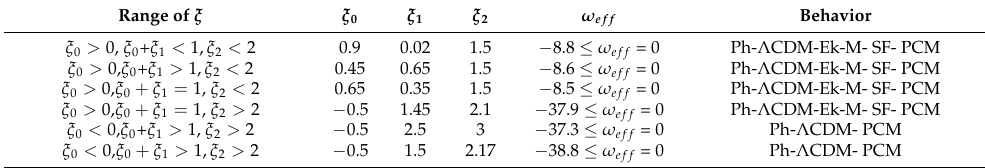
Table 3. The cosmological evolution and behavior of EoS parameter for the limiting case of ξ . Range of